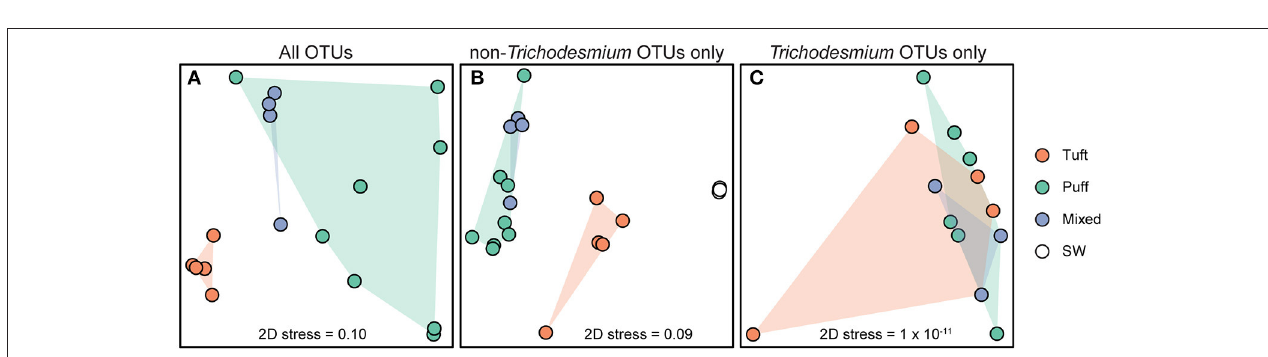
FIGURE 3 | Non-metric multi-dimensional scaling (NMDS) plots derived from the Bray–Curtis dissimilarity matrix of 16S rRNA OTUs from (A) all Trichodesmium colony sample OTUs (7011 sequences per sample), (B) Trichodesmium colony and surface seawater samples excluding Trichodesmium OTUs (3128 sequences per sample), and (C) Trichodesmium colony samples excluding non- Trichodesmium OTUs (2248 sequences per sample). Each point represents an individual sample. Colors represent sample type [tuft colonies, puff colonies, mixed colonies, and bulk seawater (SW) from 25 m].